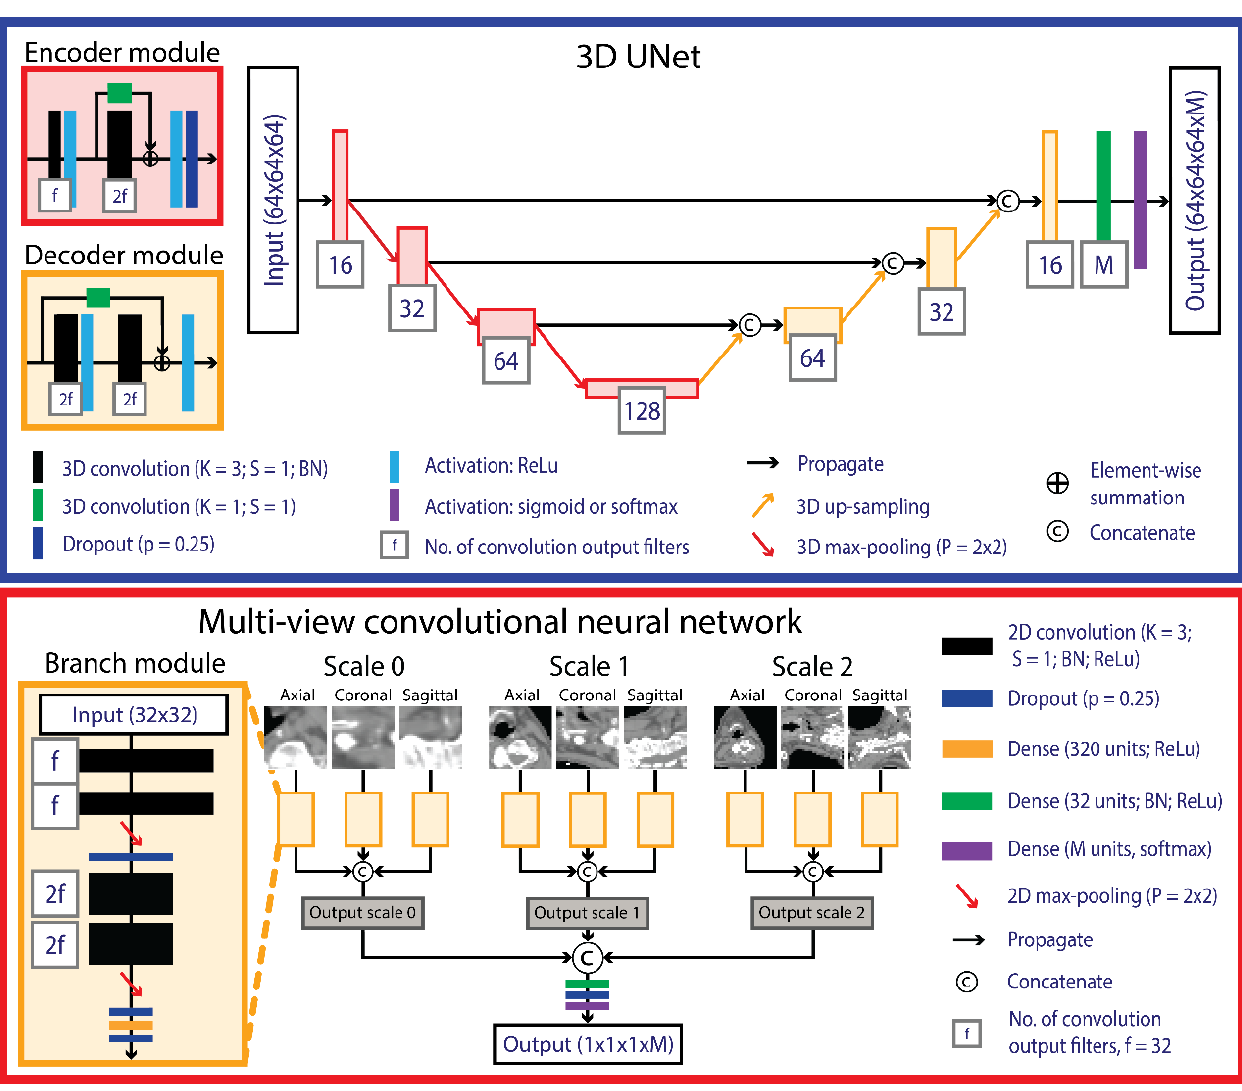
Figure 2. Schematic overview of the UNet (blue box) and MV (red box) networks. UNet consists of an encoder ( left ) and a decoder ( right ) pathway that generates binary segmentation maps from 64 cubed voxel patches sampled from planning CTs. MV uses three multi-view branches that build up to each anatomical plane within a scale block, the output of which is concatenated and used as the input for the multi-scale branched architecture. The thickness of the convolutional blocks corresponded with the number of filters used. The number of output classes (M) was six for UNet in the UNet-only configuration and two for UNet in the UNet+MV configuration. M was six for MV in the MV-only configuration and five in the UNet+MV configuration. Abbreviations: MV: multi-view; ch: number of channels; BN: batch normalization; ReLu: rectified linear unit; f: number of output filters; M: number of output classes; K: convolution kernel size; S: convolution stride; BN: batch normalization; p: dropout fraction: CT: computed